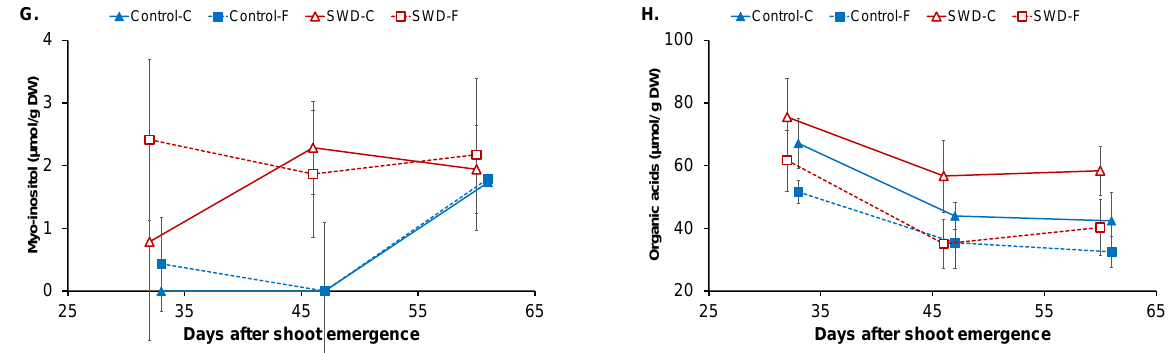
Figure 3. Evolution of ( A ) water content, ( B ) starch content, ( C ) glucose content, ( D ) fructose content, ( E ) sucrose content, ( F ) sucrose-to-hexose ratio, ( G ) myo-inositol content and ( H ) organic acid content in potato tuber tissues (C: Cortex; F: Flesh) during tuber filling expressed in days after shoot emergence for both control and severe water-deficit (SWD) conditions. Values correspond to the average of four observations ( n = 4 ) and standard deviation are indicated by the segment bars. The statistical significance of values between tissues, growth periods and water regimes is reported in Tables 1, 2 & 3, respectively. Table 1 . Statistical evaluation of the effect of tissue type on biochemical parameters (Student t-test or Mann–Whitney test; Statgraphics, alpha = 5%). Different letters between Cortex and Flesh for the same DASE indicate a statistically significant difference. DASE 32 46